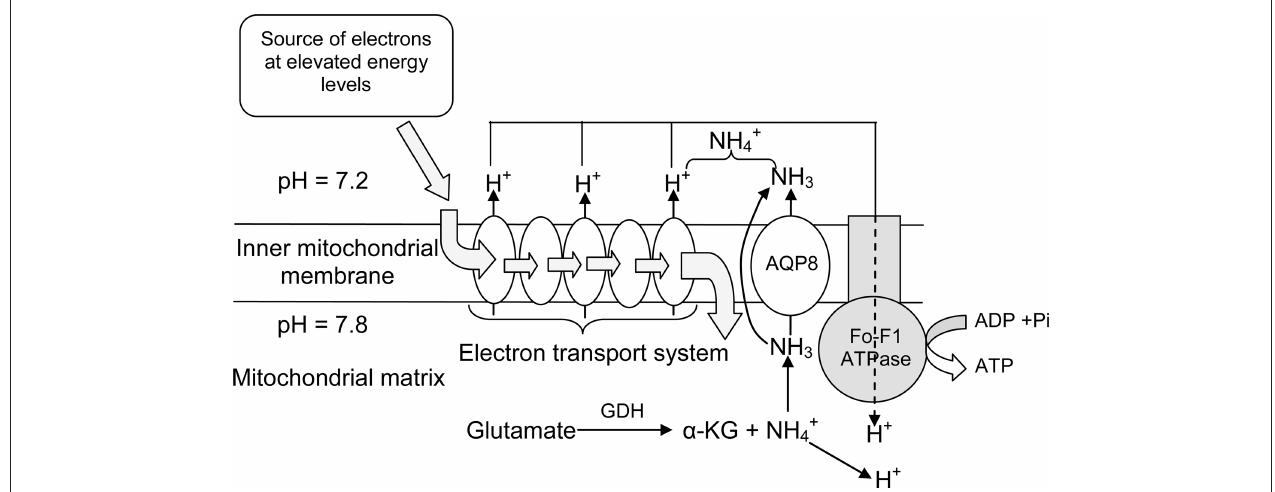
Figure 3 | The catabolism of excess amino acids through transdeamination in the liver mitochondrial matrix releases α -ketoglutarate ( α Kg) and NH 4+ through the deamination of glutamate catalyzed by glutamate dehydrogenase (gDH). Some NH 4 + would dissociate to NH and H + in the matrix which has a more alkaline pH than the 3